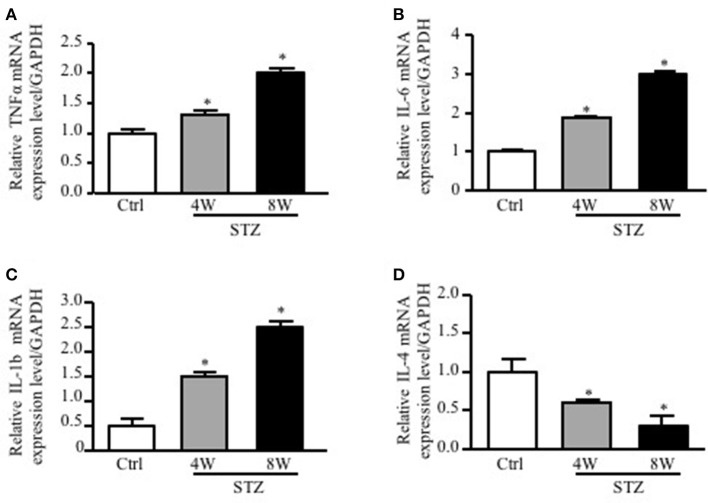
mRNA expression of inflammatory molecules in diabetic mice heart tissue. (A) TNFα level, (B) IL-6 level, (C) IL-1β level, (D) IL-4 level in the left ventricular hearts. Data are expressed in mean ± SEM (*p < 0.05 as biological significant level, Ctrl vs. STZ), n = 6.